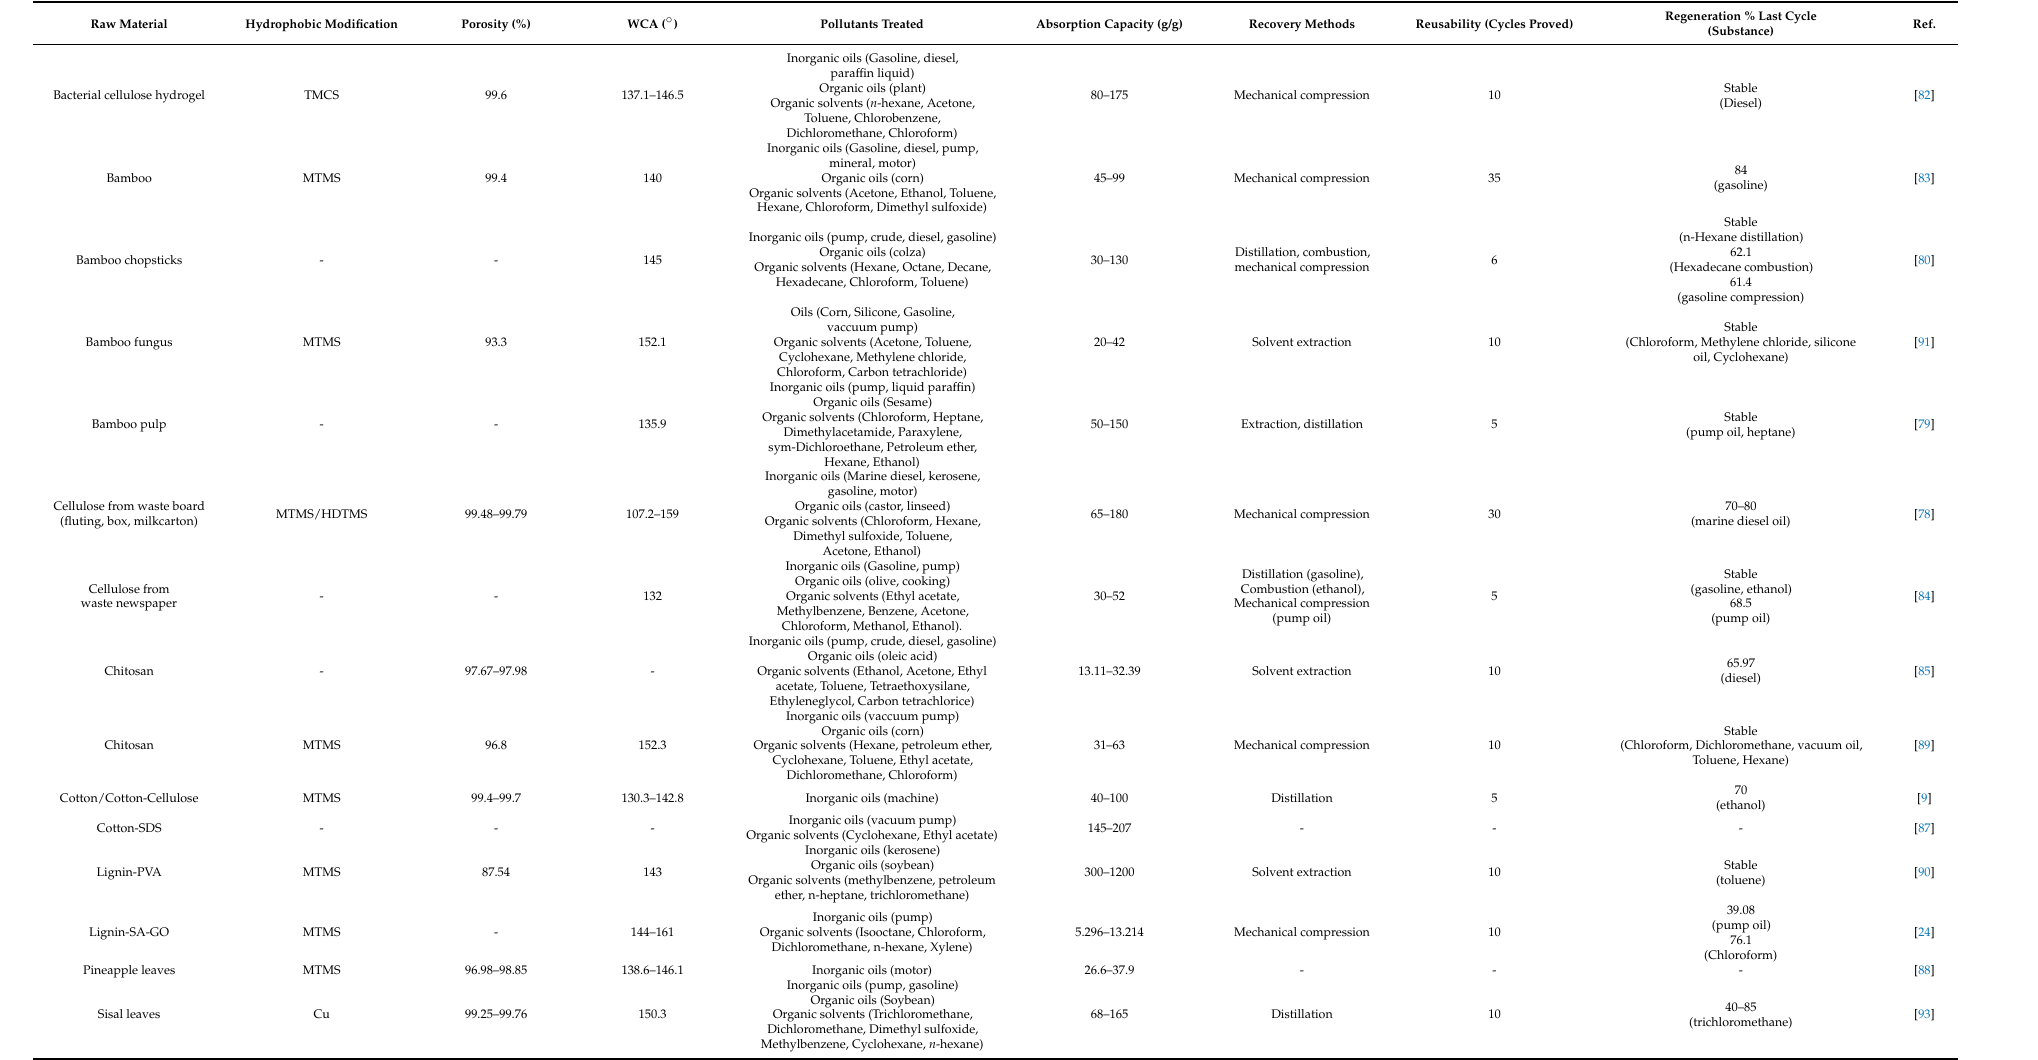
Table 1. Aerogels are used for oil/water